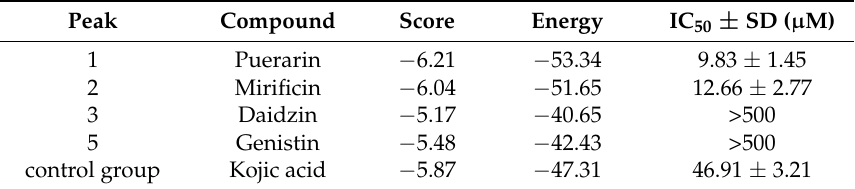
Table 2. The scores of molecular docking to the Mushroom Tyrosinase (PDB ID: 2Y9X) and TYR inhibitory activity of selected ligands and kojic acid.